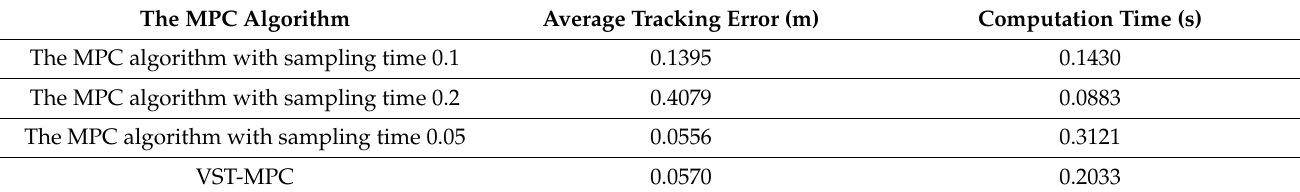
Table 3. Average tracking error and entire computation time of four MPC